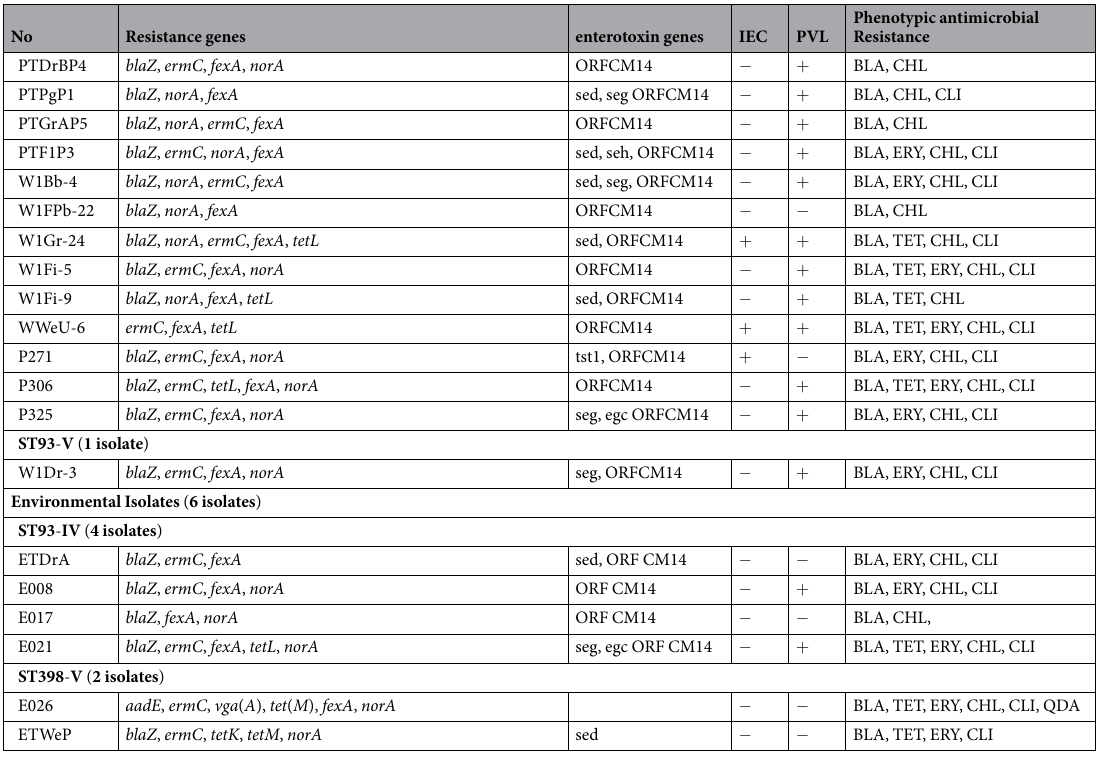
Table 2. Molecular characteristics and phenotypic antimicrobial resistance profile of MRSA isolated from farmworkers, pigs, and environment. BLA ( β -lactam), CHL (chloramphenicol), CLI (clindamycin), ERY (erythromycin), LNZ (linezolid), NEO (neomycin), QDA (quinupristin-dalfopristin), TET